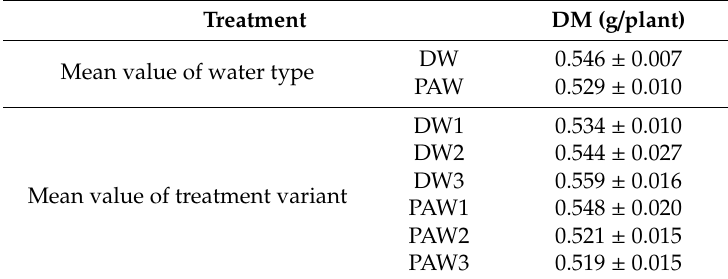
Table 6. Influence of PAW application on dry matter (DM) weight (g /